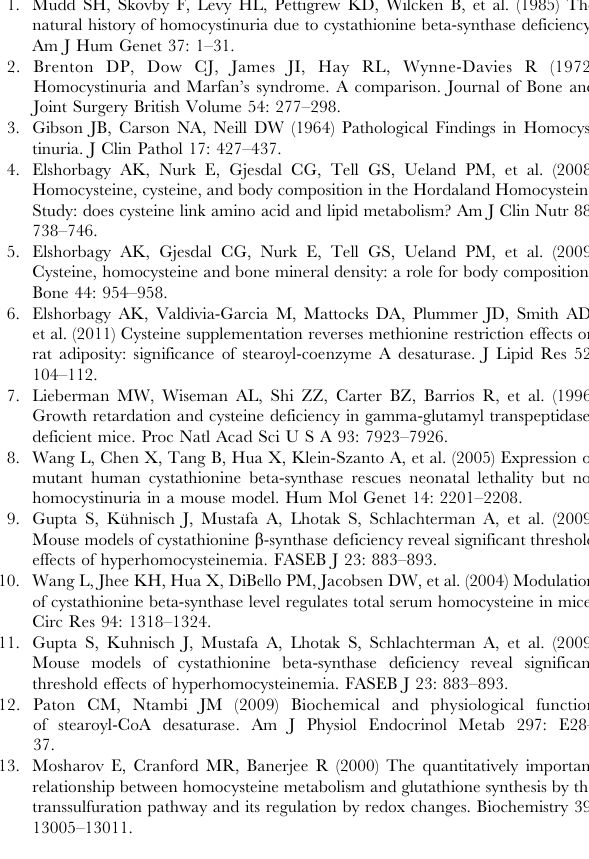
Table S1 Expression levels of selected lipogenesis genes. Previously published microarray data from the livers of Tg-I278T Cbs 2 / 2 and control mice were analyzed for genes specifically involved in lipogenesis (see reference [9]). Table S2 Comparison of serum amino acids in Tg-I278T Cbs 2 / 2 on normal and NAC containing